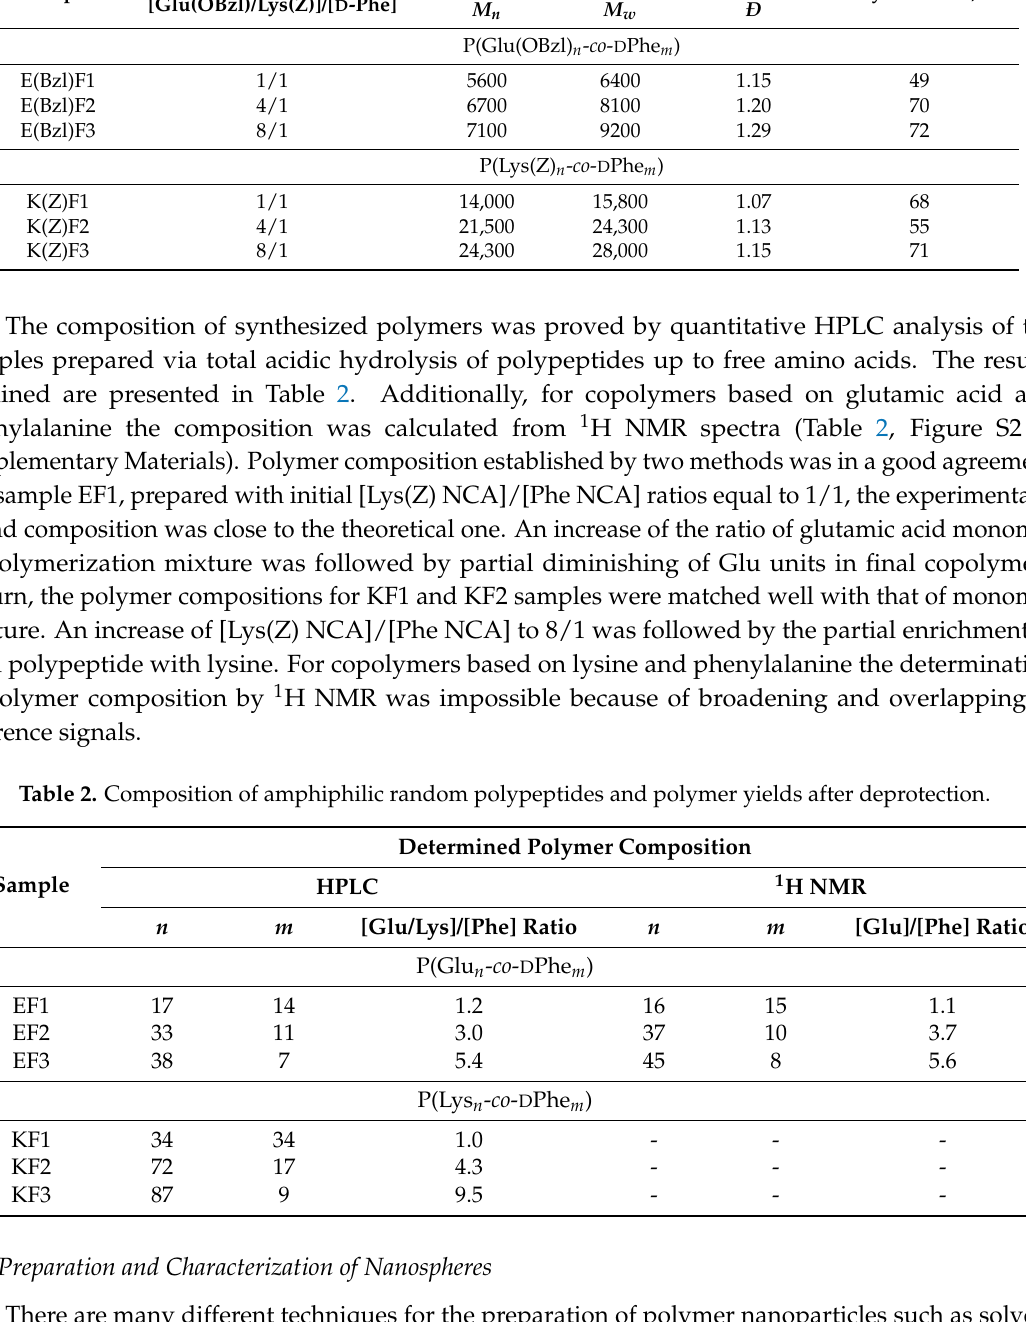
Table 1. Monomer ratios, polymer yields and characteristics of synthesized protected copolymers. Sample